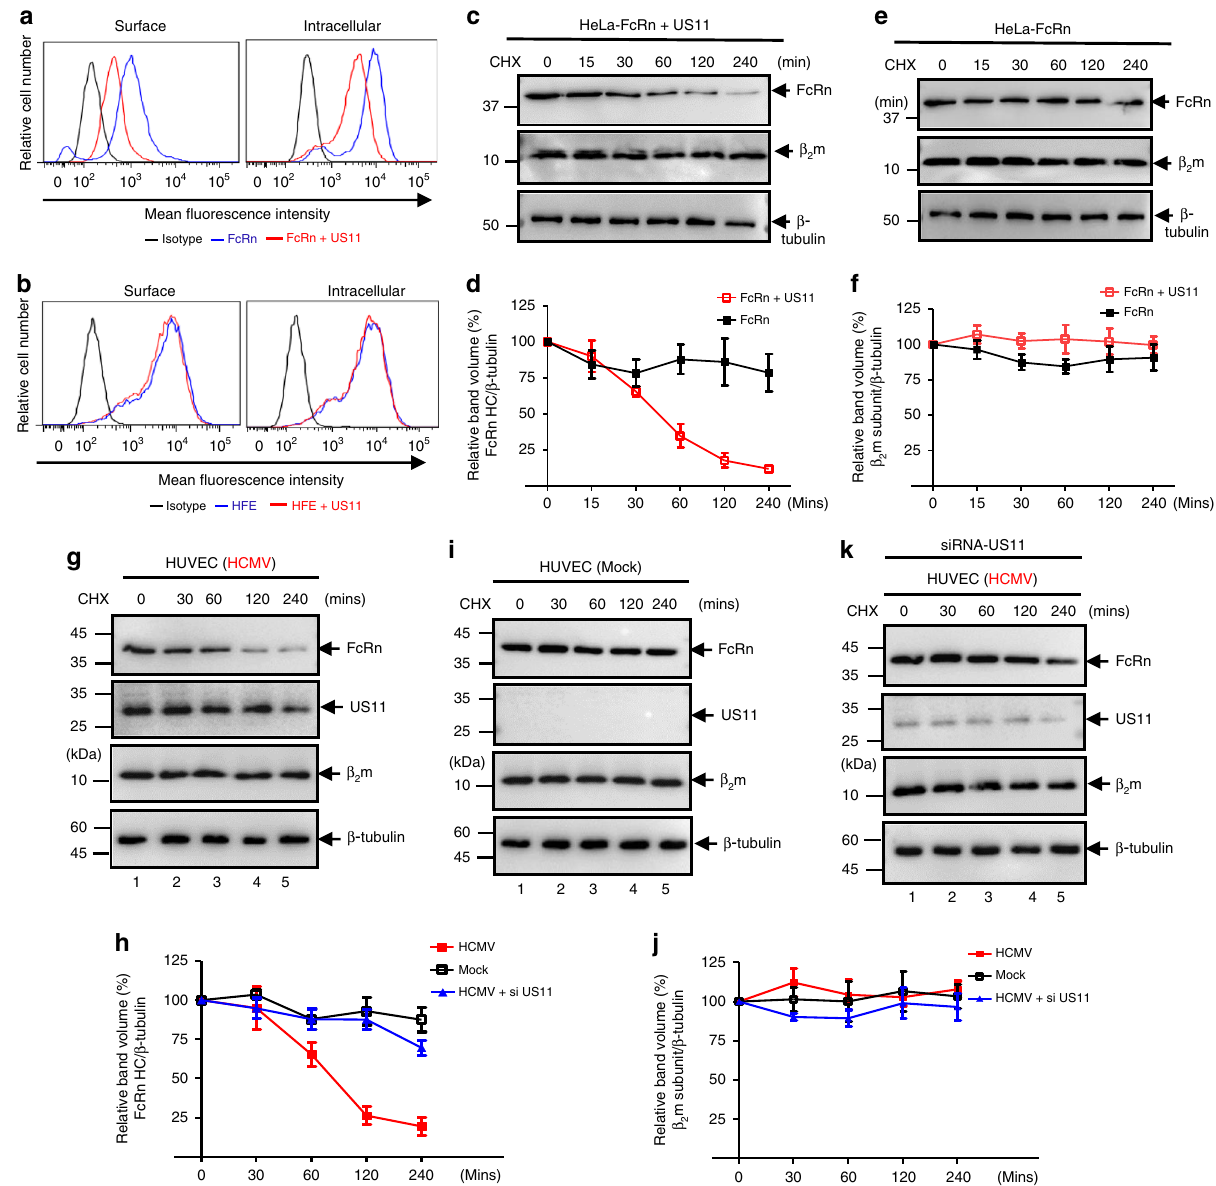
Fig. 3 US11 protein mediates FcRn degradation. a , b Cell surface and intracellular expression patterns of FcRn and HFE in either fi xed or permeabilized US11- expressing cells were measured by fl ow cytometry. Cells were stained as described in Methods. The red or blue histograms represent staining of cells with anti-FLAG (FcRn or HFE)-speci fi c Ab with or without expression of US11, and the black histograms represent cells stained with isotype-matched IgG. The staining was performed three times with similar results. The mean fl uorescence intensity (MFI) is shown on the x -axis, and the relative cell number on the y -axis. Results are expressed as histograms of fl uorescence intensity (log scale). c – f HeLa FcRn cells were transfected with US11 plasmids for 24 h. HeLa FcRn + US11 ( c ) and HeLa FcRn ( e ) cells were then treated with CHX (100 μ g/ml) for the indicated time. The cells were lysed after CHX treatment and cell lysates (20 μ g) were subject to western blotting with corresponding Abs as indicated. The level of remaining FcRn ( d ) and β 2 m ( f ) at different time points was quanti fi ed as the percentage of the β -tubulin level. g – k HUVEC cells were infected with clinic strain HCMV (MOI 5) ( g ) or mock-infected ( i ) for 48 h. The infected cells were also transfected with 20 nM US11 siRNA oligomers ( k ). Forty-eight hours later, cells were then treated with CHX (100 μ g/ml) for the indicated time. The cells were lysed after CHX treatment and cell lysates (20 μ g) were subject to western blotting with corresponding Abs as indicated. The level of remaining endogenous FcRn ( h ) and β 2 m ( j ) in HUVEC cells at different time points was quanti fi ed as the percentage of the β -tubulin level. The percentage of time point 0 (min) is assigned a value of 100% and the values from other time points are normalized to this value ( d , f , h , j ). Error bars represented mean ± SEM of three independent